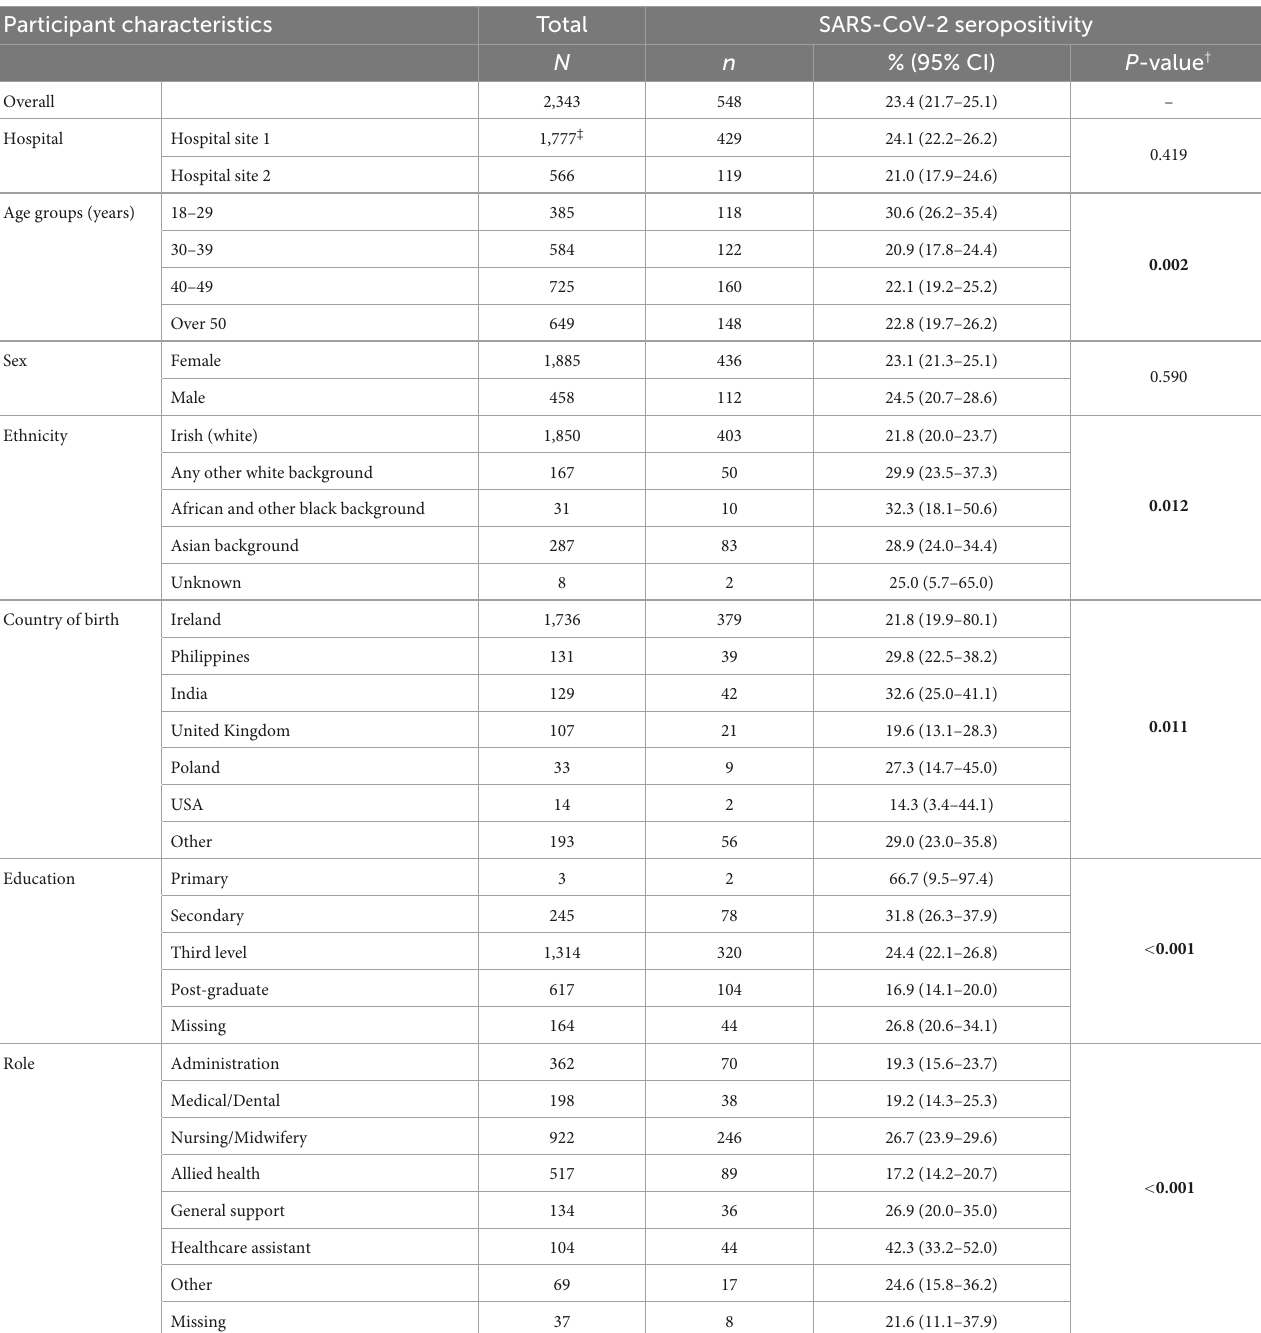
TABLE 2 Prevalence of SARS-CoV-2 seropositivity by participant characteristics, both hospitals, PRECISE 4, Ireland, November 2021 ( N = 2,343)*. Participant